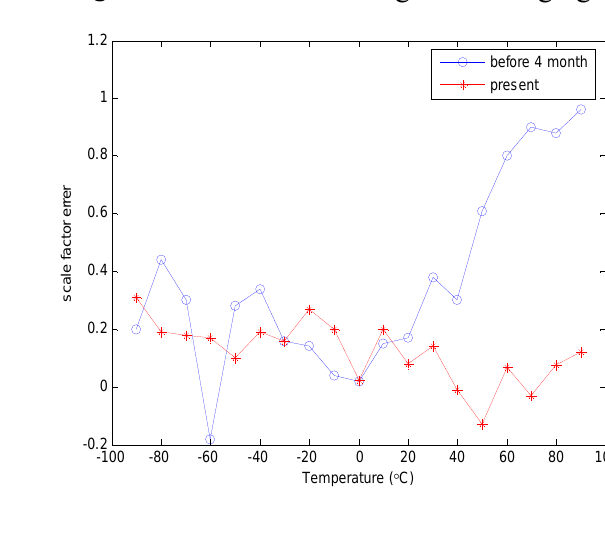
Figure 4. Thermal bias drift. Figure 5. Scale factor changes due to